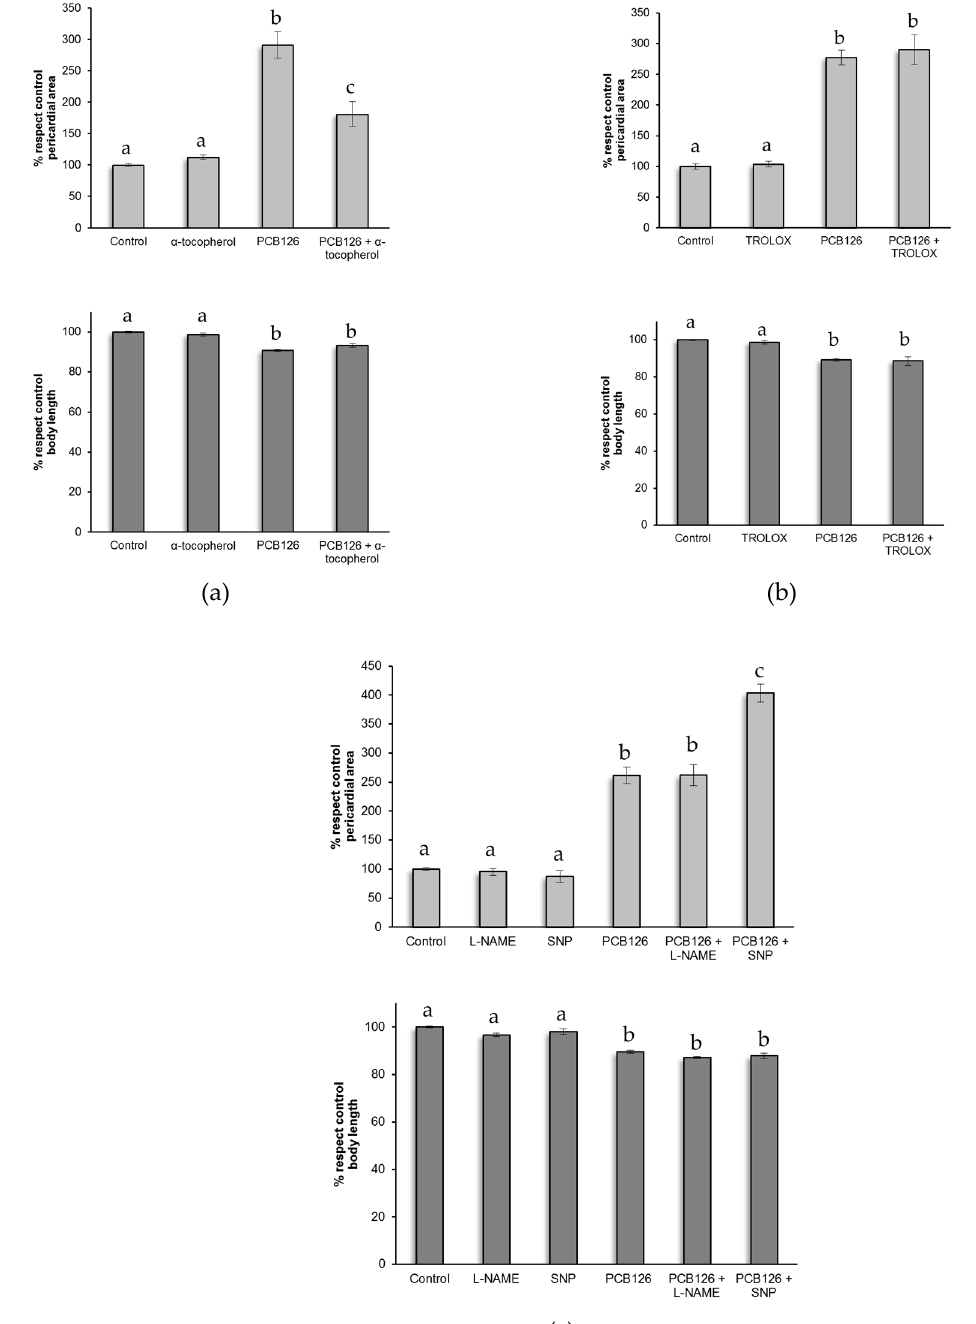
Figure 2. Pericardial sac area and body length of larvae at 80 hpf exposed to PCB126 and co-exposed to ( a ) α -tocopherol (100 µM), ( b ) Trolox (15 µM), ( c ) L-NAME (100 µM), and SNP (250 µM). Data are presented as mean ± SEM on n = 6–9 pools of three embryos. Different letters on top of the bars indicate statistically significant differences with p < 0.05.